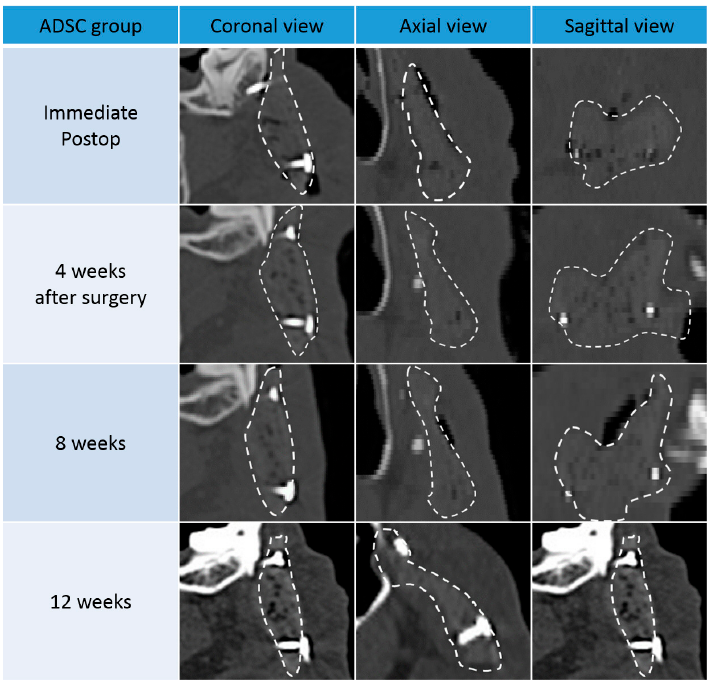
Figure 3. Computed tomography (CT) images of coronal, axial, and sagittal views from the adipose-derived stem cell (ADSC) group. Images were acquired directly after surgery and 4, 8, and 12 weeks later.